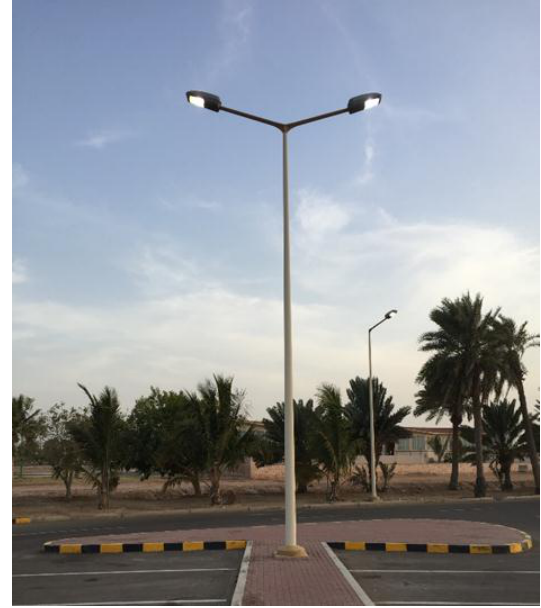
Fig. 1. Street light pole in Yanbu KSA (Shairco